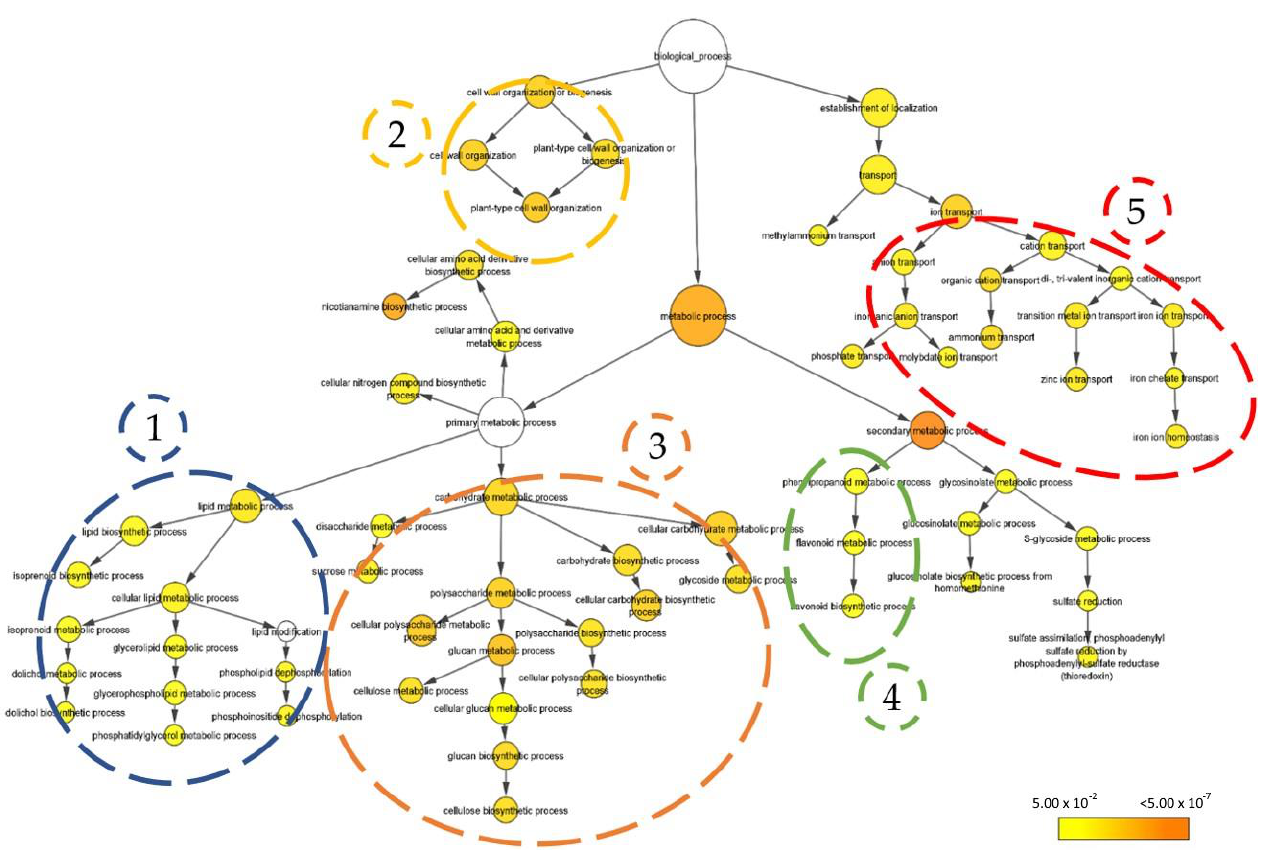
Figure 2. Plant transcriptomic regulation under inoculation with P. megaterium YC4-R4. Gene Ontology categorization of YC4-R4-induced DEGs. The size of solid-lined circles represents the number of genes in each category; meanwhile, the color indicates the significance of gene expression in each category. Clustered biological processes are indicated manually by outline-dashed circles, numbered as (1) in blue, for lipid biosynthesis; (2) in yellow, for cell wall biogenesis; (3) in orange, for carbohydrate biosynthesis; (4) in green, for phenol and flavonoid biosynthesis; and (5) in red, for metallic and organic ion transport. See Supplementary Figure S4 (heatmap).